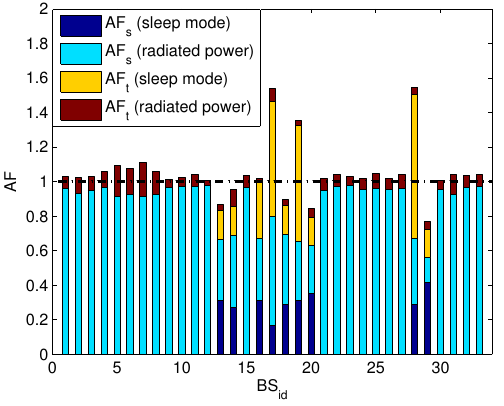
Figure 6. AF components in the